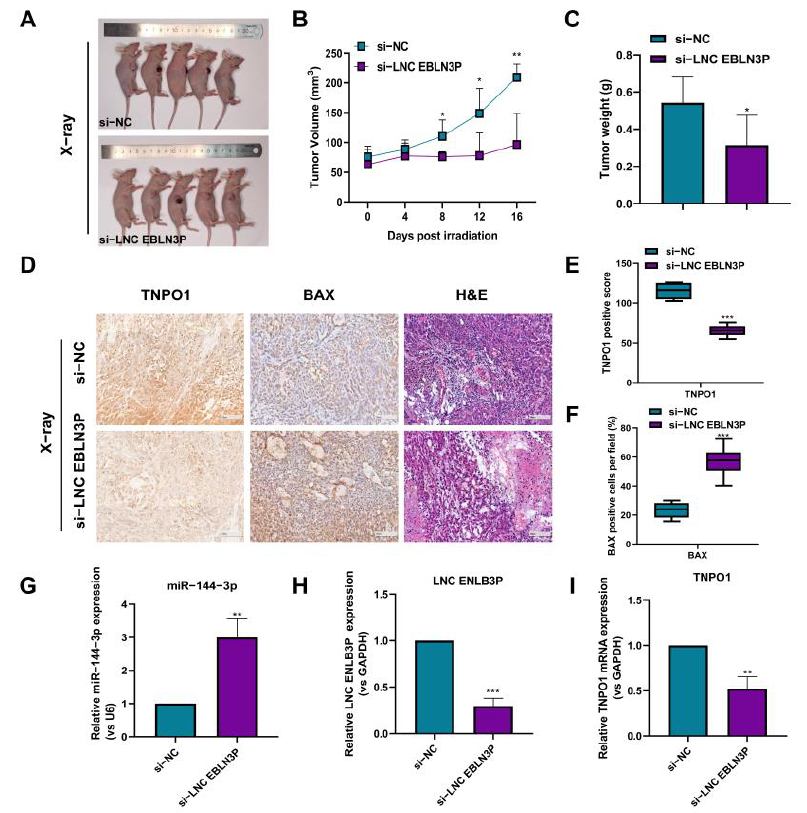
Figure 6. LNC EBLN3P silencing has the potential for radiosensitization of lung tumors. ( A ) Images of subcutaneous tumor tissues at the end of the treatment are shown. ( B ) Tumor volume changes with time. ( C ) The weights of dissected tumors are shown. ( D ) The tumor sections were subjected to hematoxylin–eosin staining and immunohistochemistry. Scale bar = 100 µ m. ( E , F ) The TNPO1 and BAX protein levels in tumor tissues (panel D) were analyzed with Image − J software. ( G – I ) The relative expression levels of miR − 144 − 3p, LNC EBLN3P, and TNPO1 in tumor tissues was examined by qRT − PCR. Data shown in ( A – I ) represent the mean ± SD ( n = 3). * p < 0.05, ** p < 0.01, *** p < 0.001.